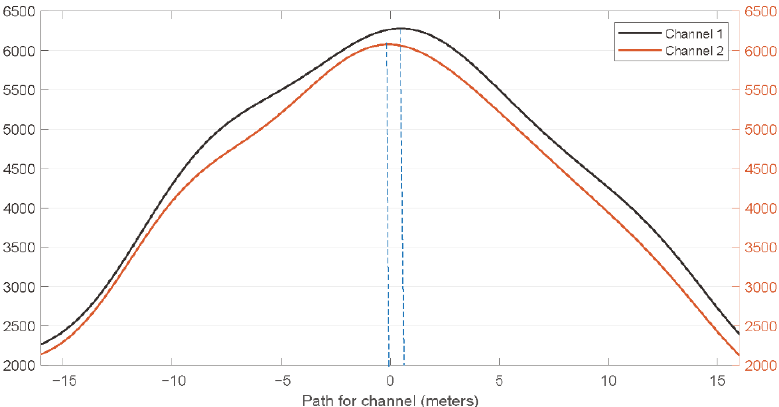
Figure 3. The calculation of code signal path differences. Code signal path differences are the path difference between the two blue lines in the figure.